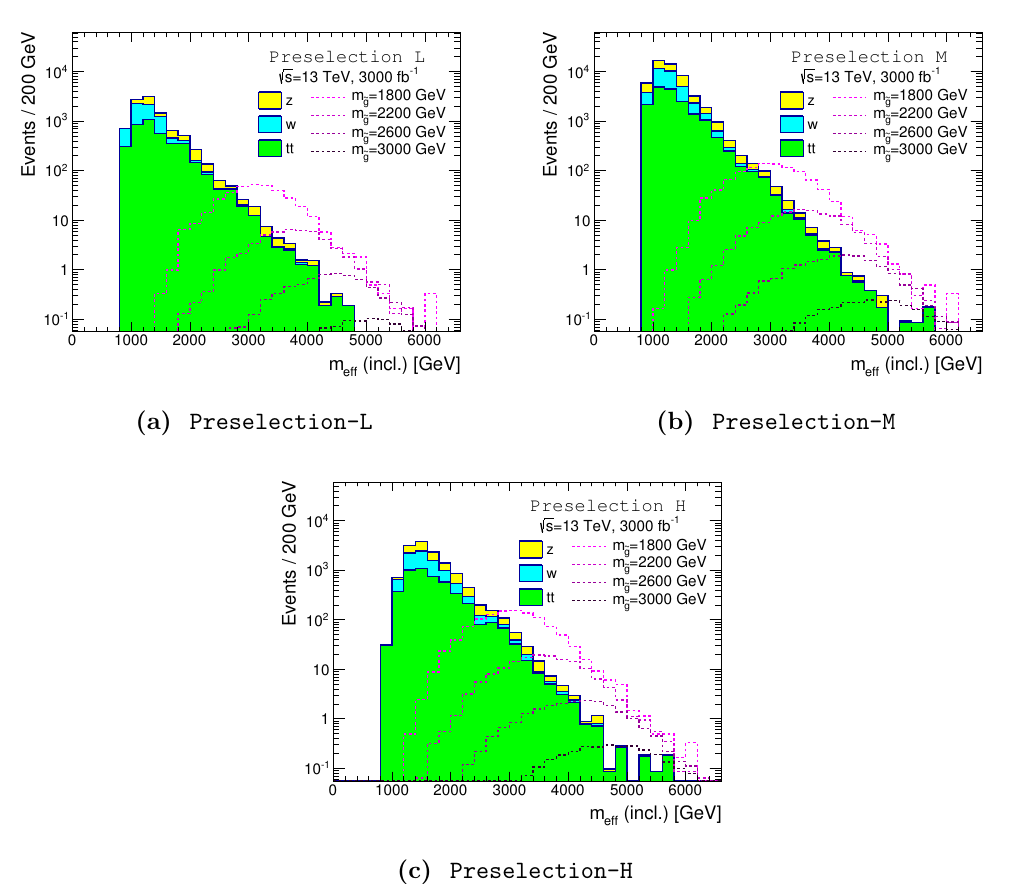
Figure 5. Distributions of m e(cid:11) (incl.) for the SM background and gluino events. We set the LSP mass to be 100